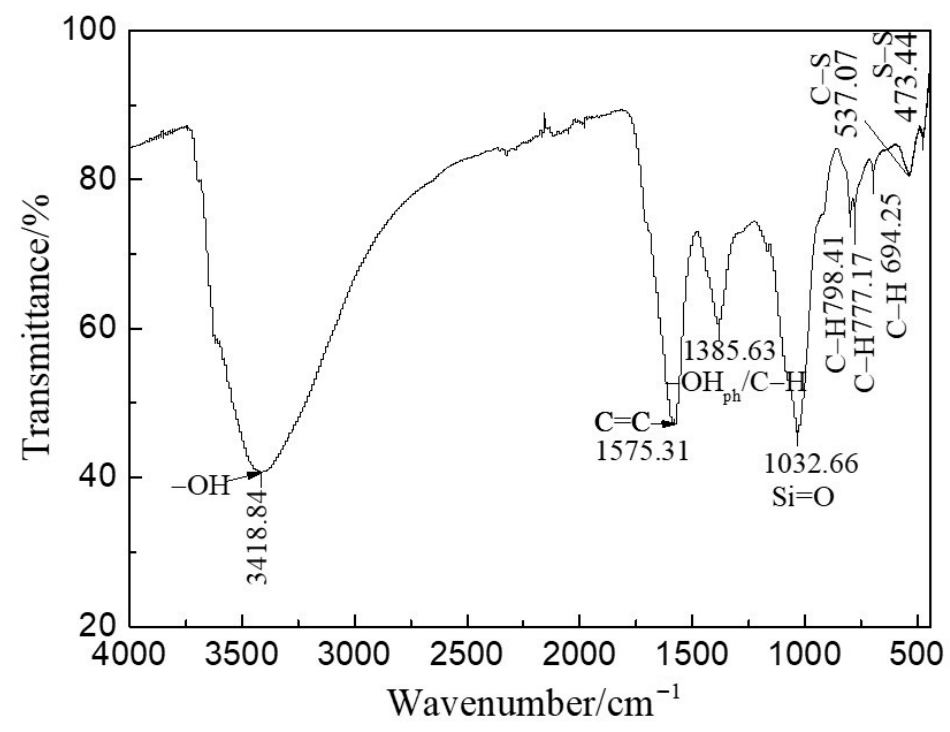
Figure 2. FTIR spectrum of HA binder.